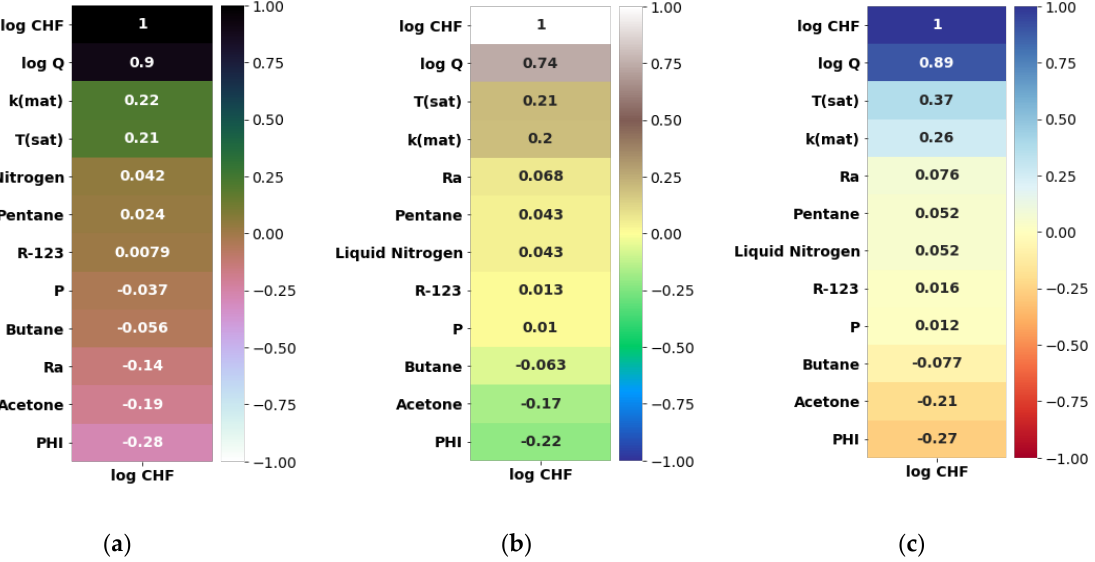
Figure 6. Correlating CHF data of dielectric liquids with categorical variables: ( a ) Pearson correlation, ( b ) Kendal correlation, and ( c ) Spearman correlation.